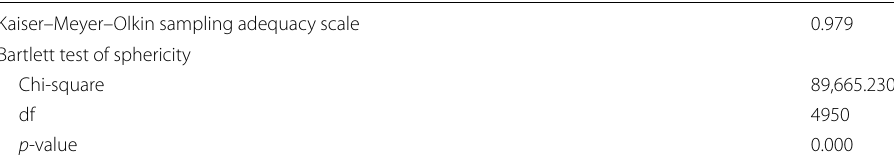
Table 2 KMO and Bartlett test of